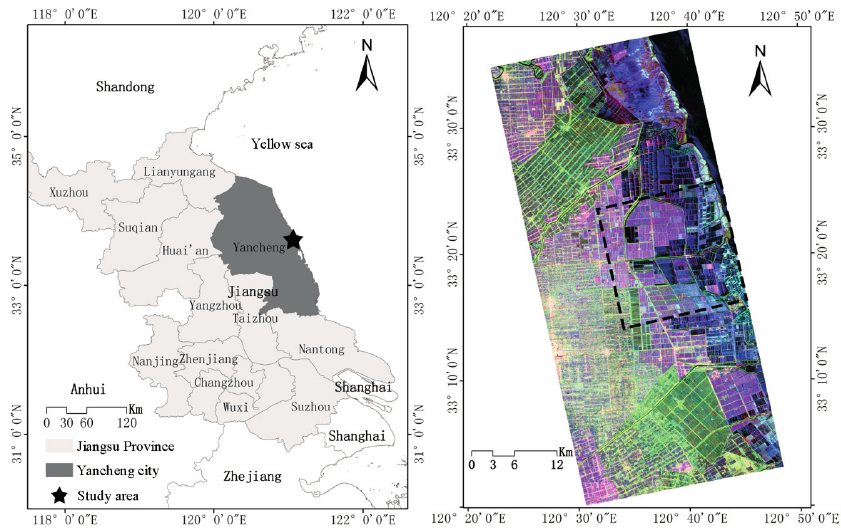
Figure 1. Map of the study area ( left ) and Pauli RGB image ( right ). The region of interest is shown in the black dashed rectangle.